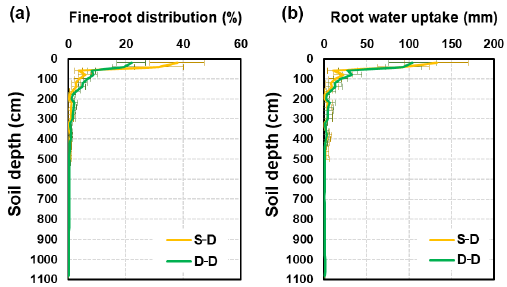
Figure 10. Comparisons of (a) infiltration amounts and (b) maxi- mum infiltration depths between the static rooting depth (S–D) and dynamic rooting depth (D–D) approaches.